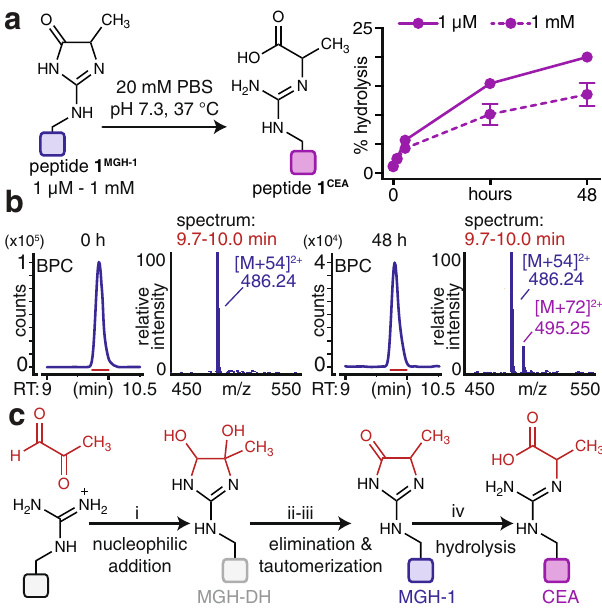
Fig. 5 MGH-1 hydrolyzes to form CEA. a Puri fi ed MGH-1-modi fi ed peptide 1 (peptide 1 MGH-1 , 1 μ M – 1 mM) was resuspended in phosphate buffered saline at pH 7.3 and incubated for up to 48 h at 37 °C. At all concentrations, peptide 1 MGH-1 was found to hydrolyze directly to yield peptide 1 CEA , as quanti fi ed by LC-MS. Data are plotted as mean values ± standard deviation, derived from independent hydrolysis experiments: 1 μ M: 0 h ( n = 4), 1 h ( n = 3), 3 h ( n = 3), 24 h ( n = 3), 48 h ( n = 3); 1 mM: 0 h ( n = 5), 1 h ( n = 5), 3 h ( n = 3), 24 h ( n = 5), 48 h ( n = 5). See also Supplementary Fig. 19). b Representative BPCs for the incubation of pure peptide 1 MGH-1 at 0 h and 48 h show the accumulation of peptide 1 CEA at later time points. We note that peptide 1 MGH-1 and peptide 1 CEA elute closely in a single chromatographic peak. However, they have distinct mass changes that can be readily resolved by our analysis software, as shown in Fig. 4c. c Potential mechanistic steps involved in the formation of AGEs derived from a single addition of MGO. The fi rst step is likely nucleophilic attack (i) of MGO by Arg to form the bis-hemiaminal MGH-DH. This intermediate undergoes elimination (ii) and subsequent tautomerization (iii) to form MGH-1. Our work further demonstrates that MGH-1 can be hydrolyzed (iv) to yield CEA. Source data are provided as a Source Data fi